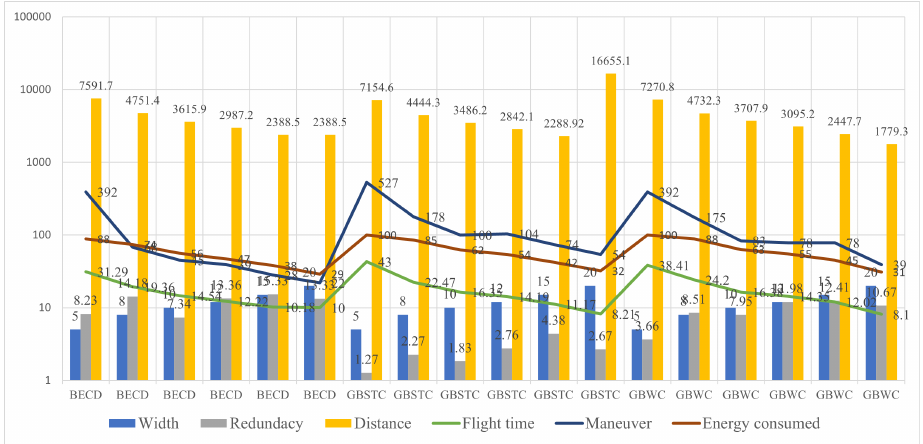
Figure 10. Performance metrics of Typhoon UAV on Arak PV plant (Experiment